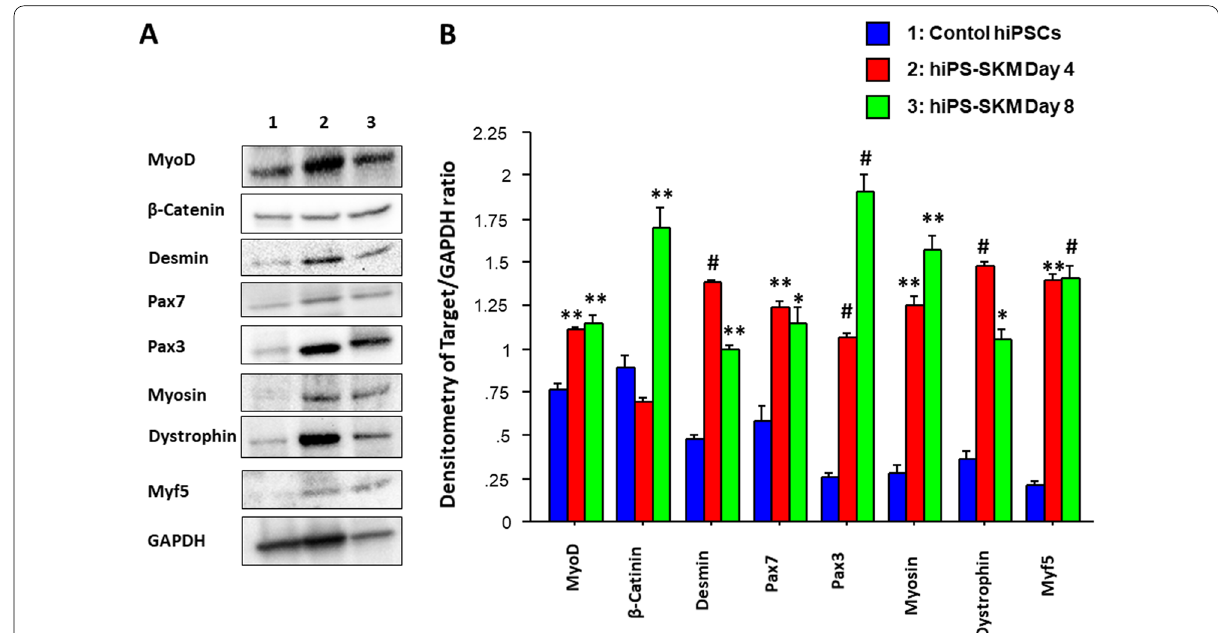
Fig. 5 Givinostat induce higher expression of skeletal myogenic proteins: Western blots ( A ) with densitometry ( B ) analysis after 4–8 days of (hiPSC-SKM) using antibodies of Pax3, Pax7, Myf5, MyoD, dystrophin, β-catenin and desmin versus control. Values are mean